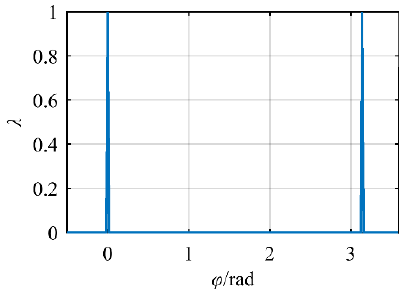
Figure 13. Type II .